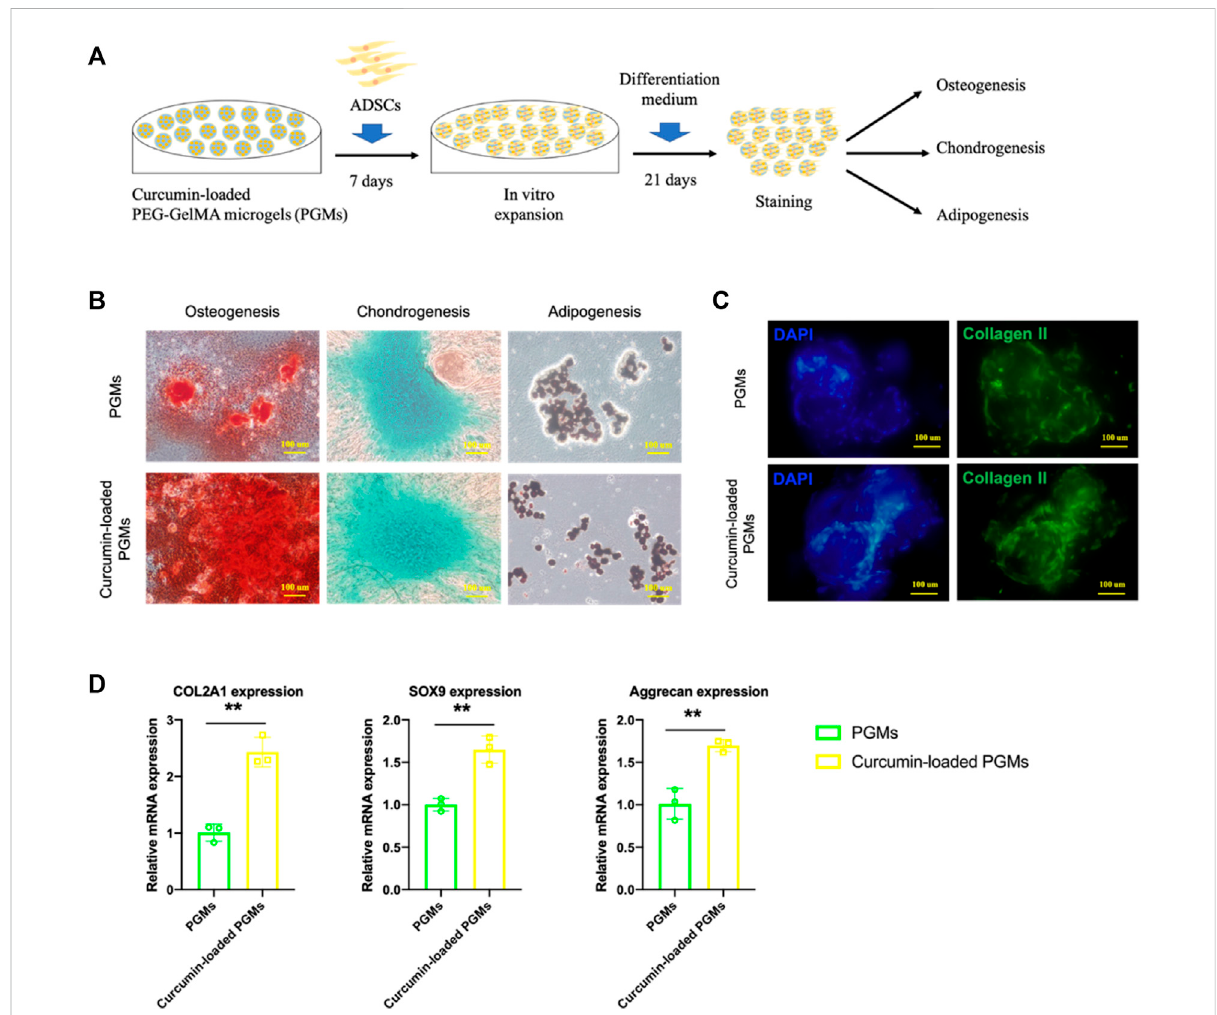
FIGURE 3 The chondrogenic bioactivity on ADSCs of curcumin-loaded PEG-GelMA microgel (PGMs). (A) Schematic of ADSCs culture on the curcumin- loaded PEG-GelMA microgel (PGMs) and further tri-lineage differentiation. (B) The level of osteogenesis, chondrogenesis, and adipogenesis of ADSCs was assessed by ARS staining, Alcian blue staining, and Oil Red staining, respectively. Scale bar = 100 μ m. (C) Immunostaining of Collagen II protein expression in ADSCs cultured on the PGMs and curcumin (5 uM) -loaded PGMs, respectively. Scale bar = 100 μ m. (D)